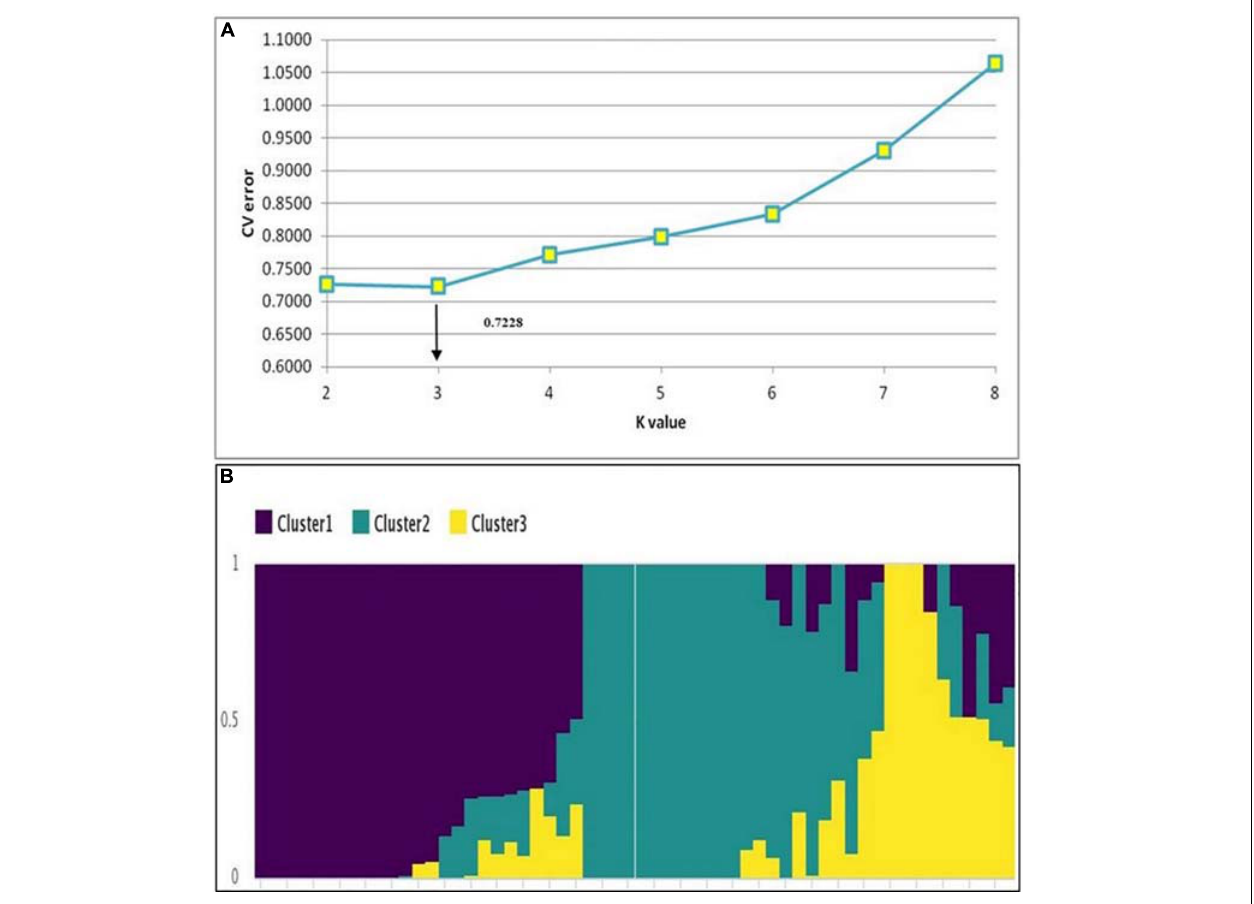
FIGURE 2 | Population structure analysis. (A) Rate of change in CV error between successive K -values; K-values ranged from 1 to 8. (B) Population structure of the 58 sorghum accessions showing three major clusters.